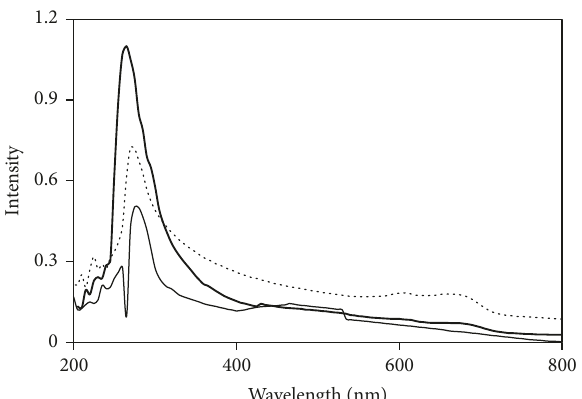
Figure 2: UV-visible spectra of pure PMMA (thin line), CoNPs/ PMMA composites (dotted line), and DBSA-CoNPs/PMMA com- posites (thick line).